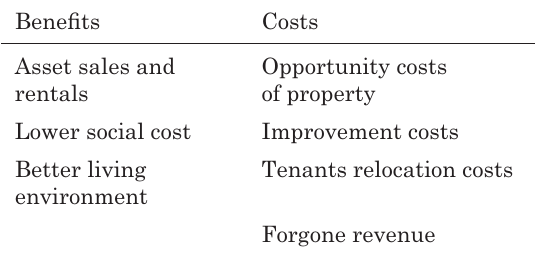
Table 1. Benefi ts and